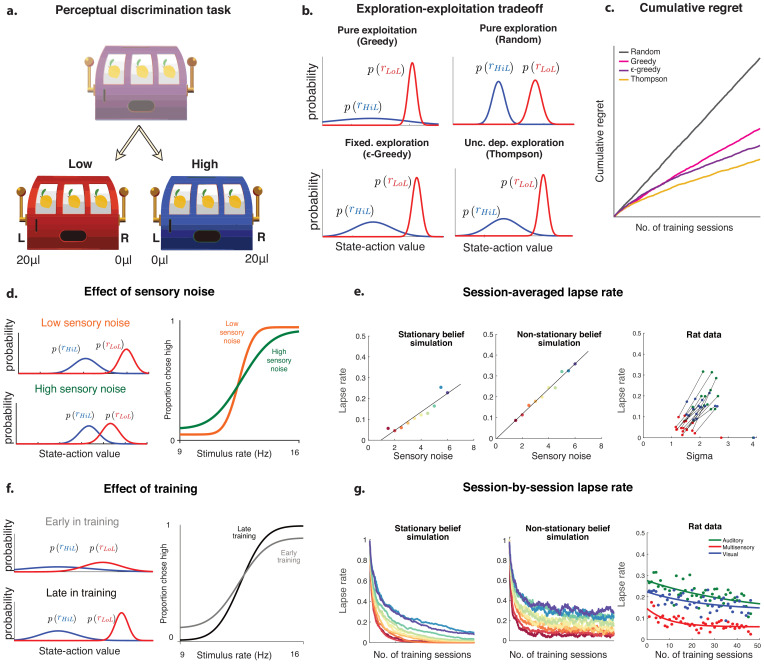
Thompson sampling, which balances exploration and exploitation, predicts lapses that increase with perceptual noise.(a) Formulation of perceptual decision-making task as a partially observable contextual bandit. To solve this task, an observer needs to infer the true category of the stimulus (Low or High) based on noisy observations, and pick the best action given the inferred category (Left for Low, Right for High). This requires accurately learning the expected rewards from all four state-action pairs. (b) Schematic illustrating the explore–exploit tradeoff: Leftward state-action value beliefs i.e. expected reward from leftward actions (L) performed in different states (Hi, Lo) showing different levels of uncertainty depending on policy. Beliefs are updated based on outcomes using a Bayesian update rule that takes into account uncertainty in state estimation. A greedy policy (top left) that always picks the best action maximizes reward and learns well about the preferred state-action pairs (i.e. Lo-L) but has high uncertainty about the non-preferred pairs (Hi–L). A random policy (top right) earns reward at chance, but learns equally well about all state-action pairs. An ε-greedy policy (bottom left) learns well about the non-preferred pair, but leaves the choice of ε unspecified, and continues exploring even after it has learnt the values well, continuing to forego rewards. Thompson sampling (bottom right) tunes the amount of exploration to the current uncertainties in each value, and balances immediately reward-maximizing decisions with decisions that reduce uncertainty, maximizing average reward in the long term. (c) Cumulative regret, i.e. foregone reward accrued by different policies on the rate discrimination task as a function of training, with lower regret being more desirable. Black – random exploration, Pink – greedy, Purple – ε-greedy, and Yellow – Thompson sampling. Thompson sampling outperforms all other policies by achieving the minimum regret. (d) Learnt beliefs about expected reward with Thompson sampling at various levels of perceptual uncertainty. Low levels of sensory noise (left top) produce more separable beliefs, while higher levels of sensory noise (left bottom) lead to large perceptual uncertainty, yielding highly overlapping belief distributions owing to a reduced ability to assign obtained rewards to one of the states. (Right) Simulated performance averaged across 2000 trials of the Bayesian observer, under a Thompson sampling policy. The observer makes fewer exploratory choices for lower levels of sensory noise (orange) owing to the more separable value beliefs, giving rise to lower lapse rates. (e) Session-averaged lapse rates as a function of sensory noise in simulations (left, center) and multisensory rat data (right). Simulations were done under increasing levels of sensory noise (colors going from hot to cold) under beliefs that action values are stationary (left) or non-stationary (center), solid lines indicate linear best-fit. Individual rat data was fit with a constrained version of the exploration model where total lapse rate was constrained to be linearly related to sensory noise across all modality conditions (auditory – green, multisensory – red, and visual – blue). Lines indicate best fit linear constraints for each rat. (f) Learnt beliefs about expected reward with Thompson sampling during early (left top) and late (left bottom) stages of training. Training reduces uncertainty about expected rewards, producing more separable beliefs and yielding less exploration and lower lapse rates over time (right – simulated average performance). (g) Session-wise lapse rates in simulated (left, center) and rat data (right) as a function of both training and sensory noise. Simulations show decreasing lapse rates over training that asymptote at zero under stationary beliefs (left) and to nonzero values dictated by sensory noise under non-stationary beliefs (center). Rat data was separated by session starting from the earliest day of training with all three modalities, and combined across rats to produce session-wise fits, and the resulting lapse rates were fit with an exponential curve for each modality (solid lines indicate best-fit curves for multisensory – red, visual – blue, and auditory – green).